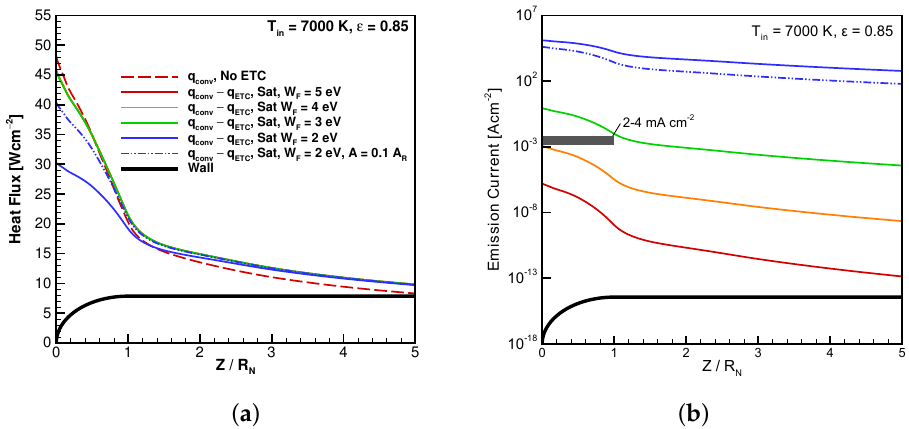
Figure 11. ( a ) Net heating rates to surface in radiative equilibrium. ( b ) Emission current, J e , line style and color correlate to the ETC modeling options specified in ( a